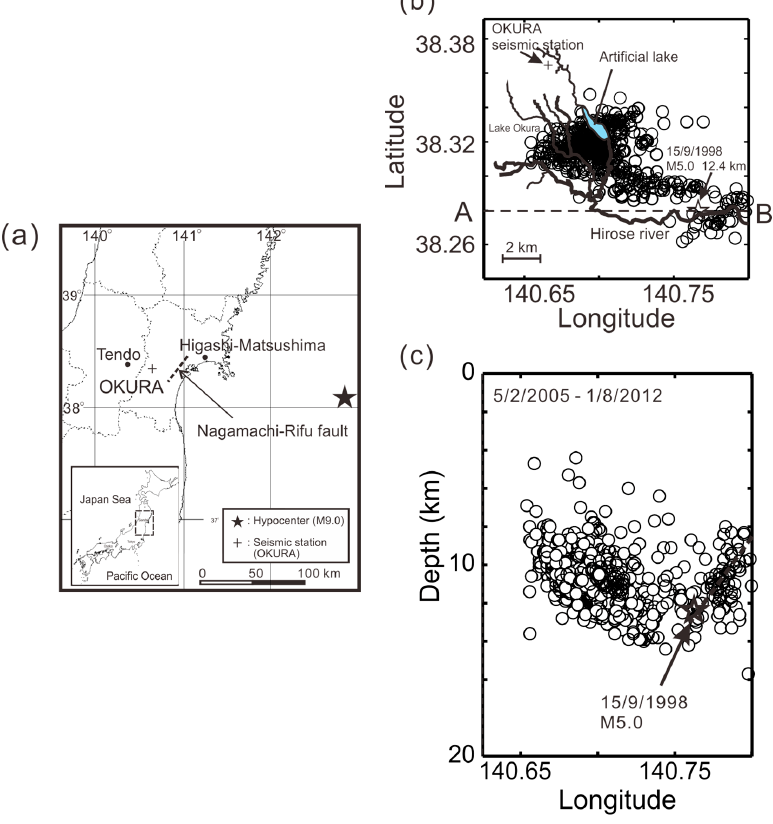
Figure 1. ( a ) Map of northeastern Honshu, Japan, with inset showing location of study area. The solid star marks the epicenter of the Tohoku earthquake; ( b ) Map showing epicenters of micro-earthquakes from 5 February 2005 to 1 August 2012; ( c ) Vertical cross section showing hypocenters of micro-earthquakes projected onto line A–B. Open stars show the location of the magnitude 5.0 earthquake of 15 September 1998.